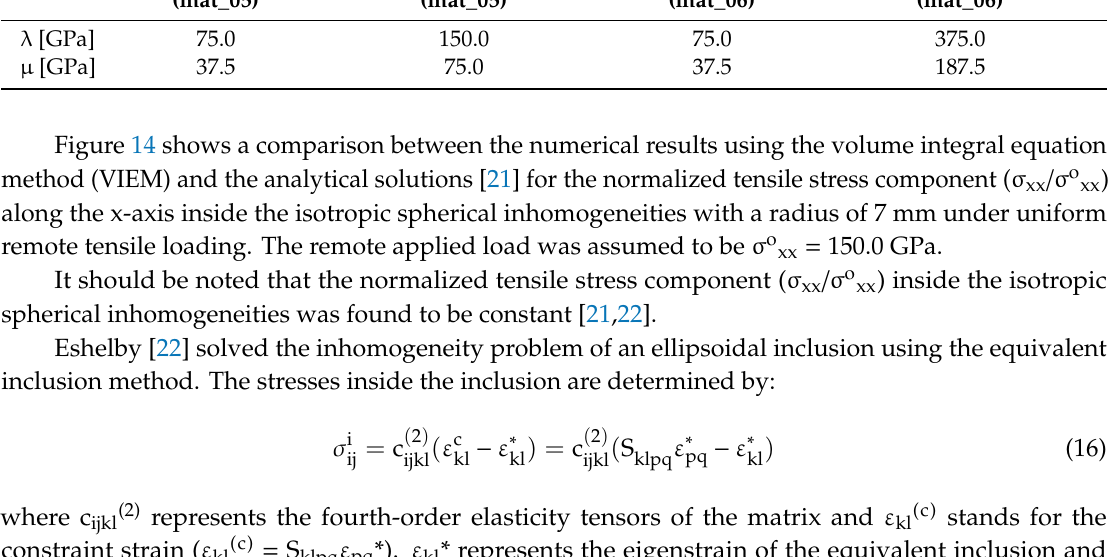
Figure 14. Comparison of the numerical results using the volume integral equation method (VIEM) and the analytical solutions for the normalized tensile stress component (σ xx /σ oxx ) along the x-axis inside the isotropic spherical inclusions with a radius of 7 mm under uniform remote tensile loading.